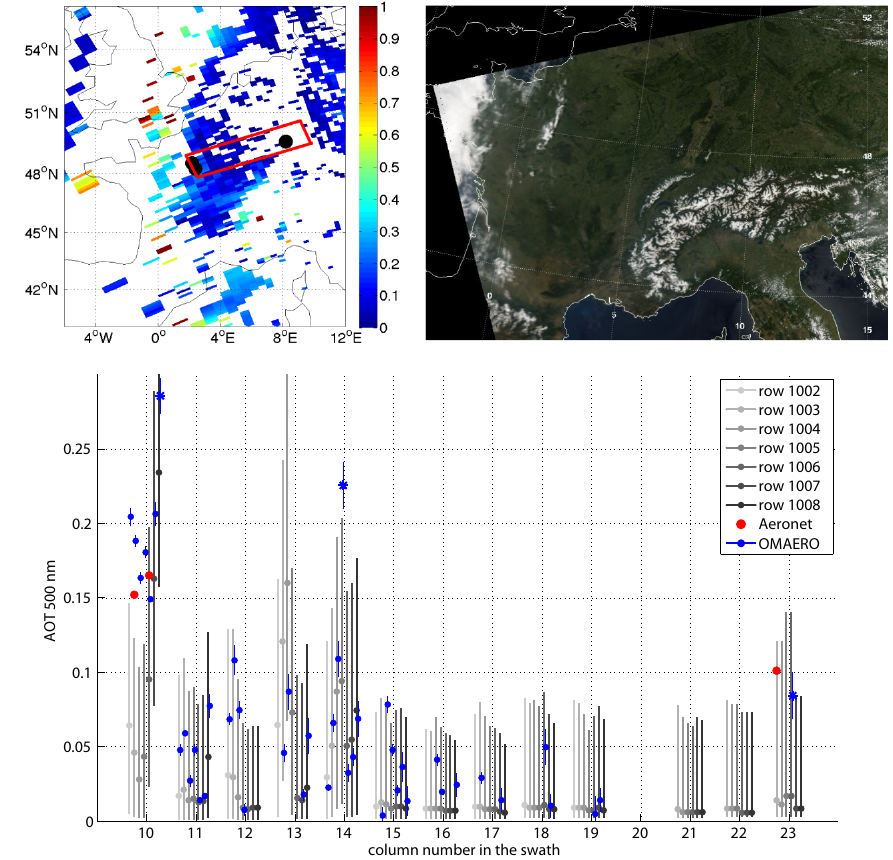
Fig. 10. The top left panel shows AOT from the official OMAERO product. The data are from one orbit (o10153), 12 June 2006. The top right panel shows a MODIS true-colour image from the same day. The lower panel shows AOT values and their uncertainties for a selection of pixels, marked as a red rectangle at the top left. The pixel indexes vary from columns 10 to 23 and rows 1002 to 1008. Each column of seven pixels has been grouped together along the horizontal axis. The vertical axis shows AOT at 500nm reference wavelength. Not all individual pixels were available, due to cloud contamination. The vertical lines with different shades of grey correspond to the rows of pixels in the satellite orbit and show the results of the retrieval algorithm using model averaging and accounting for discrepancy. The grey dot is the mode of the posterior distribution and the line spans 95% of the posterior probability mass. The blue dot is the best fit model from the operational OMAERO algorithm (also shown on the top left panel) with 2 times standard error uncertainty indicated by the blue line. Three OMAERO values, marked with a star, did not pass the operational goodness of fit threshold. The three red dots show AOT values from collocated AERONET stations, whose locations are shown as black dots in the top left panel. See the text for a discussion of the